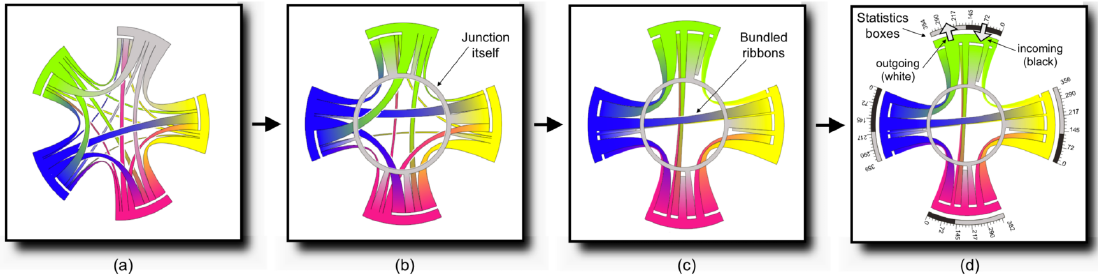
Figure 25. The interchange Circos diagram for visualizing interchange patterns in juction nodes [92]. In ( a ), the original form of the Circos diagram is featured. The improved visualization in ( d ) is obtained by representing junction nodes ( b ) and bundling ribbons ( c ).